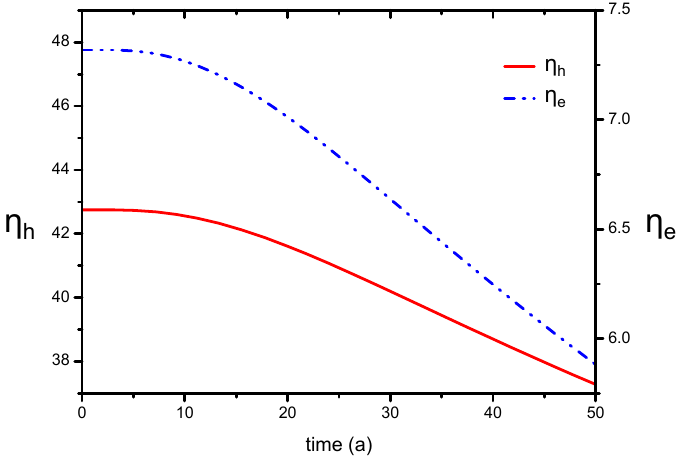
η η and e . Figure 7. Evolution of energy efficiency η h and η e .